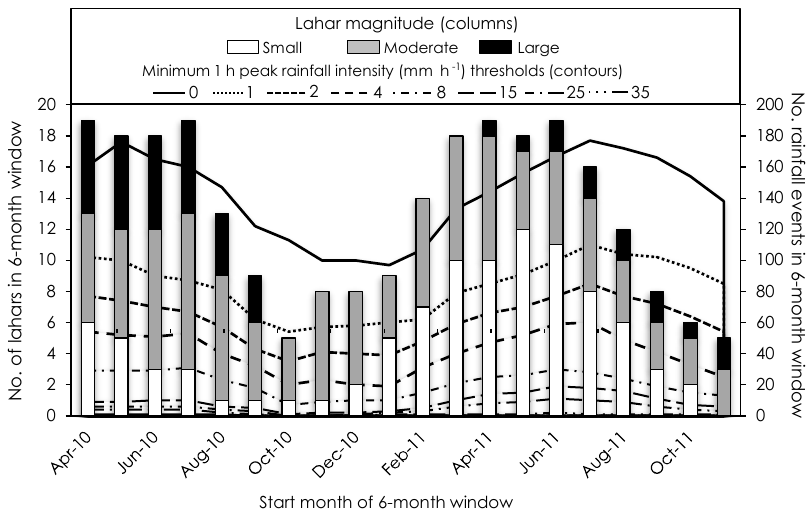
Figure 4. Illustration of the seasonal fluctuations in lahar occurrence displayed using 6-month data windows with 1-month staggered start dates. Vertical bars indicate the number of lahar events, categorised by magnitude, in each 6-month period. Background contours display the number of rainfall events exceeding specified 1h peak rainfall intensity (1hPRI) thresholds in each 6-month period.